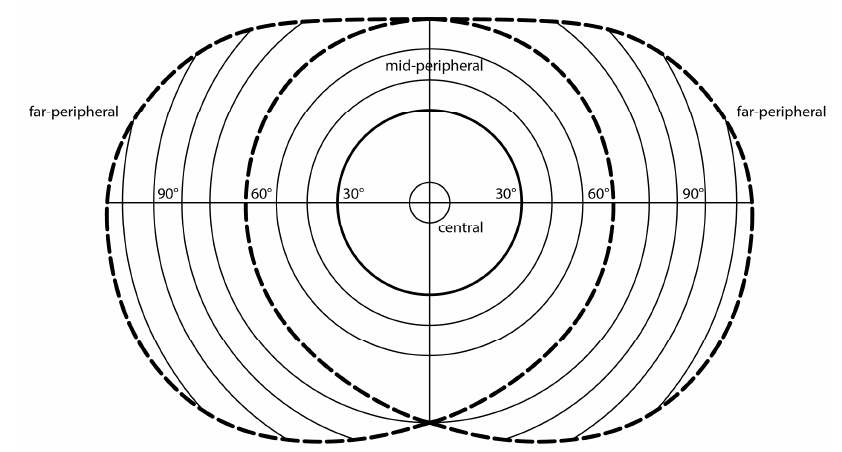
Figure 2. Field of view of the human